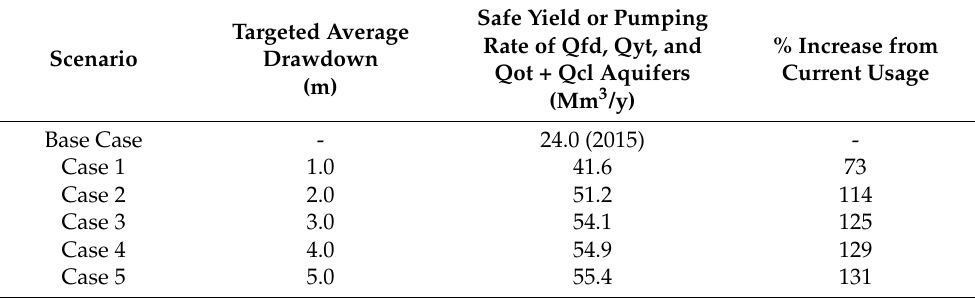
Figure 18. Groundwater recharge and groundwater storage of the unconsolidated aquifers (Qfd, Qyt, Qot) from 2007–2019. Table 4. Safe yield evaluation based on targeted drawdown (from current water